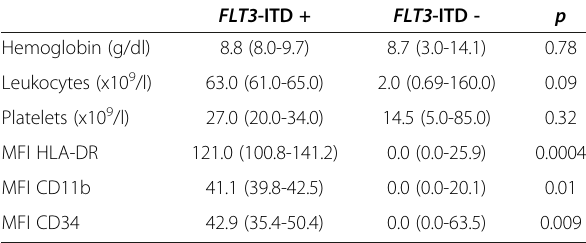
Table 5 Hematological and phenotypic features of the patients according to presence of FLT3 -ITD